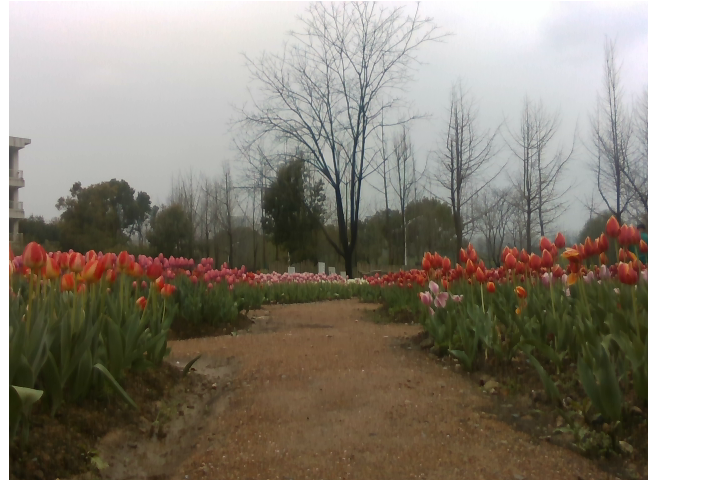
Figure 2. Original image.